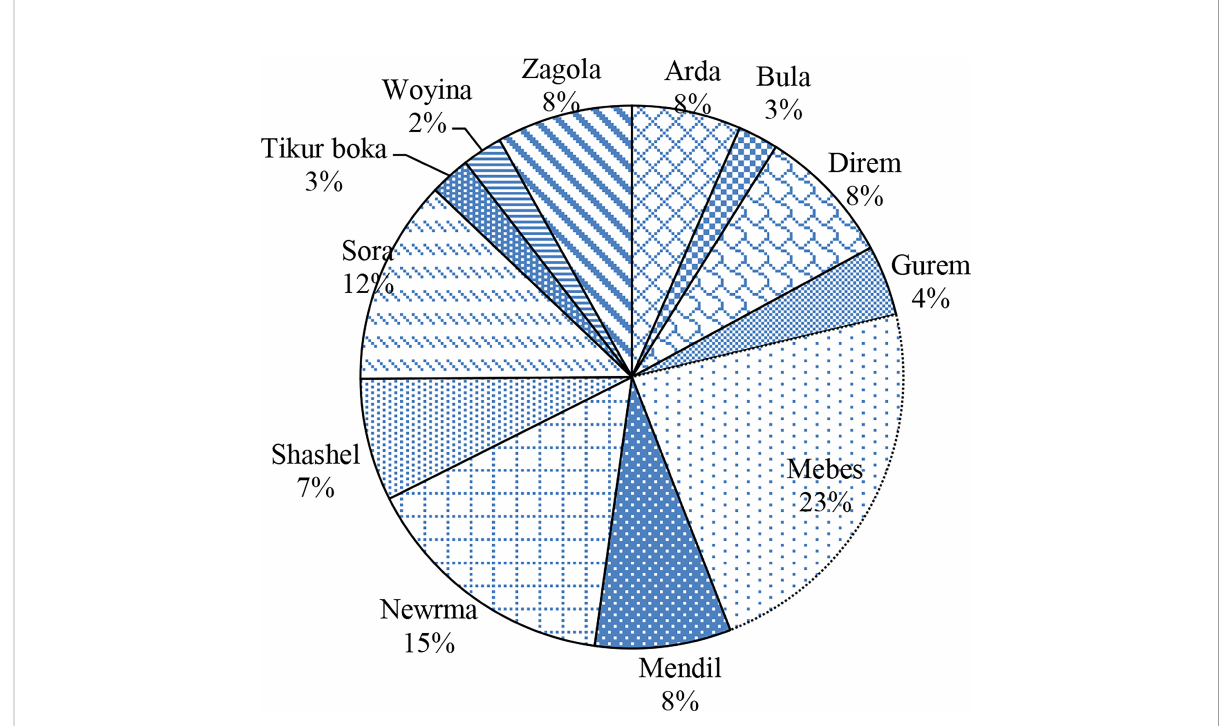
FIGURE 6 Local names of the Fogera cattle breeds.